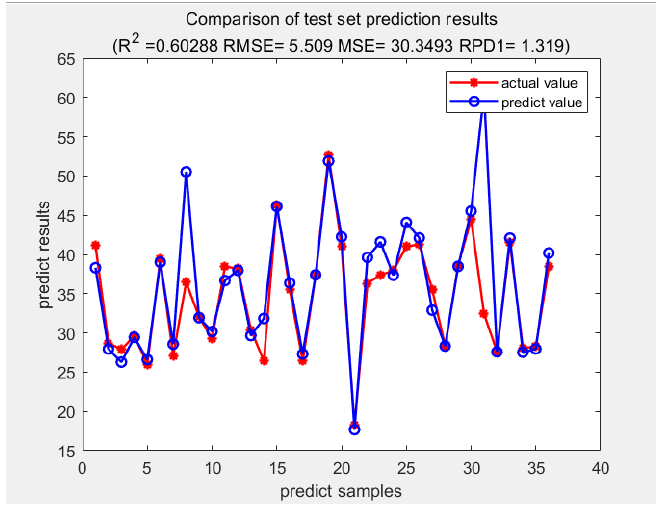
Figure 8. Actual value and predicted value in the test